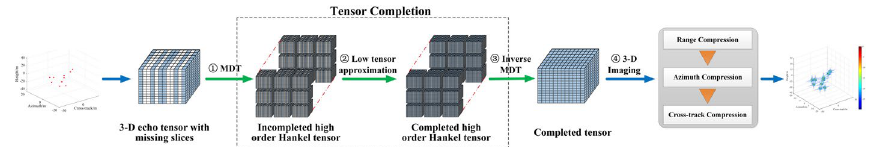
Fig. 2 The flow diagram of the proposed